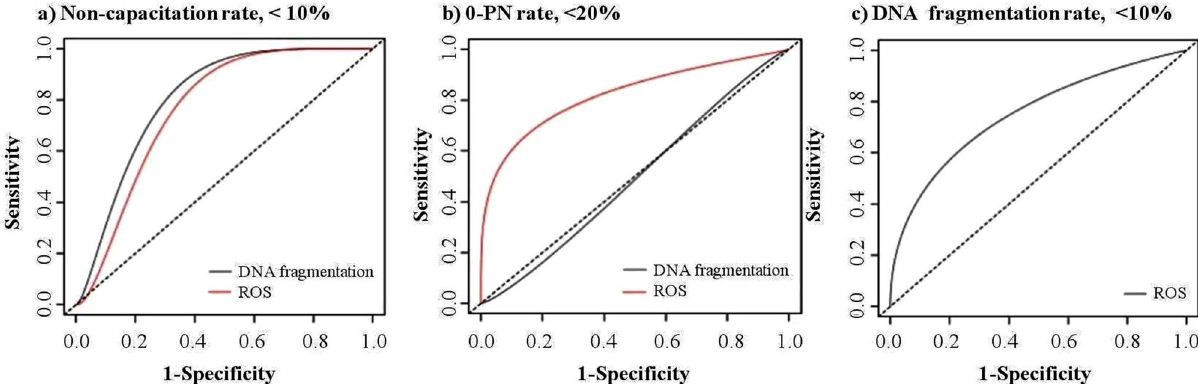
Figure 8. ROC analysis to describe the predictive power of the parameters to discriminate against low sperm quality. Using the easyROC web-tool, an analysis of the receiver operating characteristic (ROC) curve was done on the basis of the network analysis outputs that determined links between the sperm parameters. The analysis was carried out by determining the predictive power and the cut-off point of the network-detected parameters for the detection of high sperm quality by the area under the ROC curve (AUC). The optimal cut-off was determined by maximizing the Youden index. In order to address possible biases in the findings generated by assuming that any relationship between ROS production and non-capacitation and 0-PN rates could be linear, the results were divided into separate categories as follows: (1) low rate of non-capacitation (< 10%); (2) low rate of 0-pronuclear (0-PN, oocyte which did not reach the 2-PN stage, < 20%); and (3) low rate of DNA fragmentation (< In addition, the urea-incubated sperm cells had a low HOS test score compared to the control and EGF groups, but the EGF reduced the adverse effect of urea on the HOS challenge. In other words, urea canceled the positive effect of the EGF on HOS-positive sperm cells. The HOS test evaluates the ability of the sperm plasma membrane to transport water when confronted with hypo-osmotic solutions. This thereby induces sperm swelling